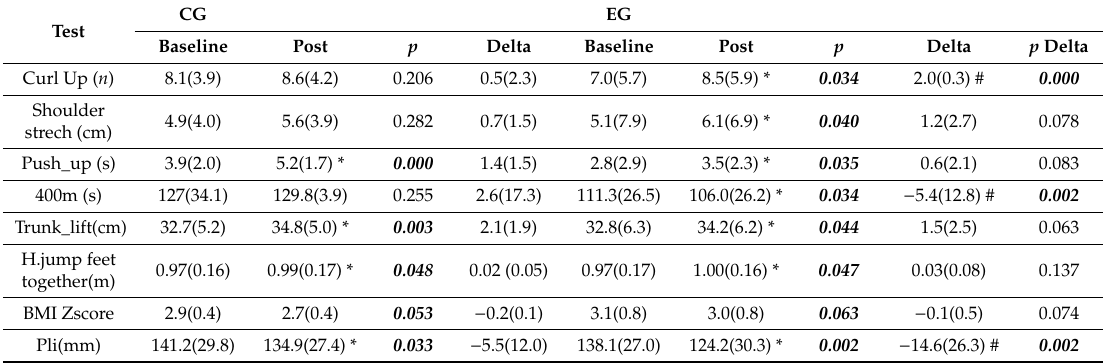
Table 3. Evaluation of the physical condition before and after the intervention and the pre-post differences.